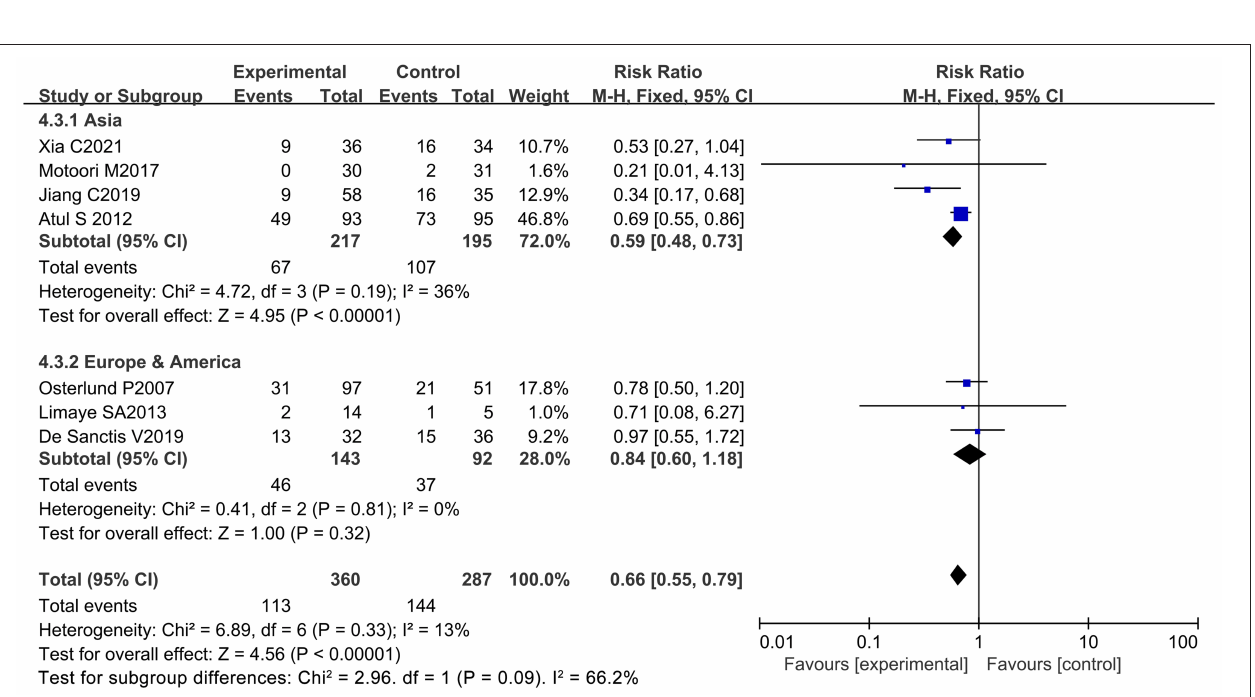
Frontiers in Nutrition |